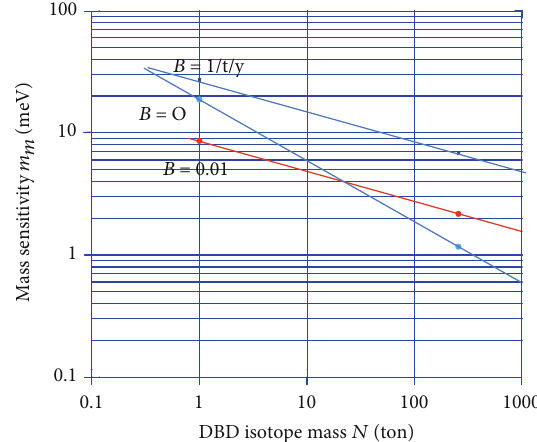
for η = 1 : 0 , 0.5, and 0.1 as m Figure 5: Neutrino mass sensitivities m isotope-mass N in cases of B = 1 , 0.01, and 0. The exposure time is T = 5 y. The unit mass m 0 ′ = 40 meV and M 0 ν = 2 , ε = 0 : 55 , and η = 0 : 9